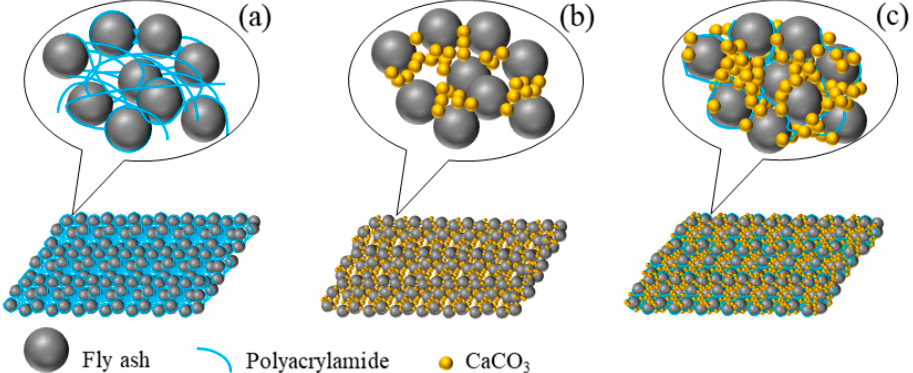
Figure 7. Schematic diagrams for curing mechanisms of FA treated with chemical, biological, and chemically-biological